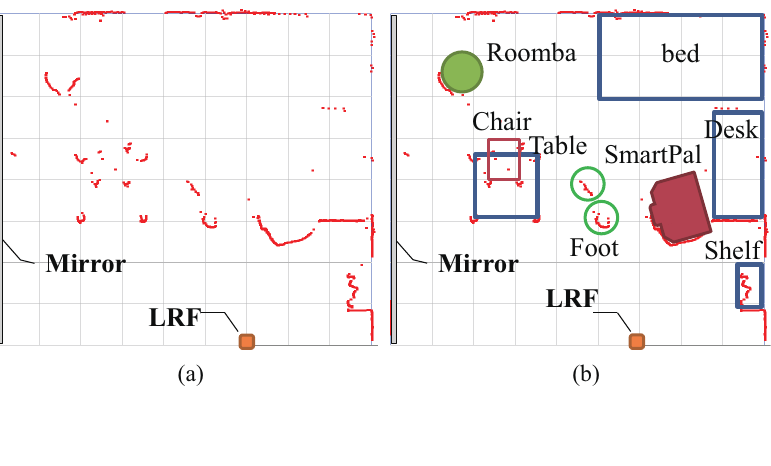
Figure 14. Original data by LRF and identification of objects: ( a ) original data points, ( b ) identification of